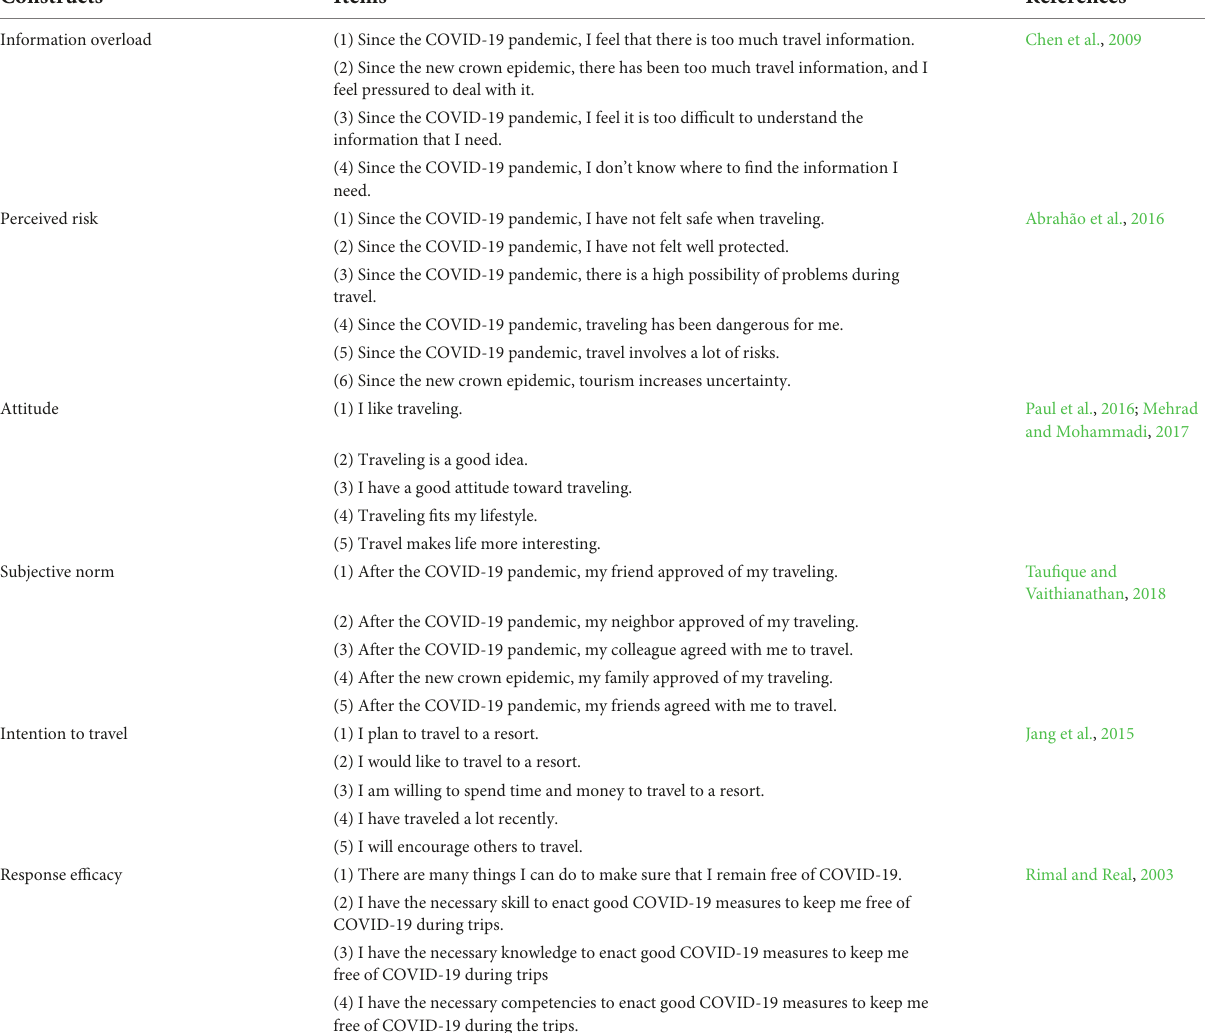
TABLE 1 Measurement items and